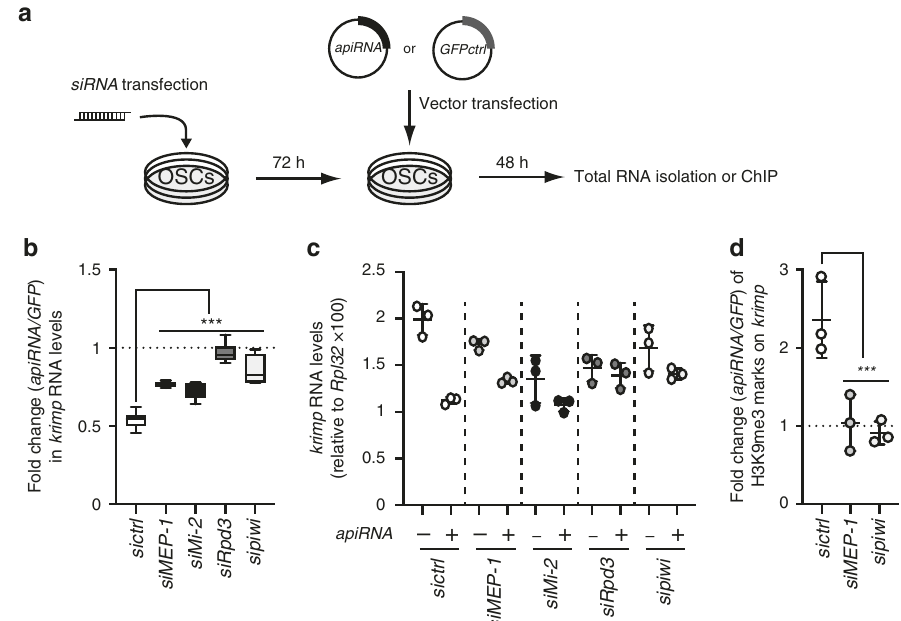
Fig. 5 MEP-1, Mi-2, and Rpd3 involvement in piRNA-dependent repression. a Schematic representation of the krimper ( krimp ) piRNA-mediated repression assay after siRNA-mediated depletion of MEP-1, Mi-2, Rpd3, or Piwi in OSCs. Transfection of the apiRNA vector allows the production of antisense arti fi cial piRNAs against krimp . Transfection of the GFPctrl vector is used as a piRNA-less negative control. b Fold change (relative to GFPctrl) in krimp RNA levels caused by apiRNA in OSCs previously transfected with the indicated siRNAs. RNA levels were quanti fi ed relative to RpL32 . Box plots display median (line), fi rst and third quartiles (box), and highest/lowest value within 1.5× interquartile range (whiskers) for n = 6 values calculated over three independent samples. The siRNA effect was tested using the ANOVA test and differences using the pairwise t-test. P-values were calculated using sample data that displayed normal distribution (tested with the Shapiro – Wilkinson test). Variance homogeneity was tested with the Levene ’ s test and then the two-tailed Student ’ s t -test was used. *** P -value < 0.05 when each siRNA experiment is compared to the sictrl experiment. c Quanti fi cation of krimp RNA levels relative to RpL32 in OSCs transfected by the indicated siRNAs with ( + ) or without ( − ) production of apiRNAs against krimp . Note that the cells that were not transfected with the apiRNA vector were transfected with GFPctrl vector, instead. Means ± SD from n = 3 biologically independent samples are represented. d Fold change (relative to GFPctrl) of H3K9me3 marks on krimp quanti fi ed by ChIP-qPCR. OSCs were transfected with the